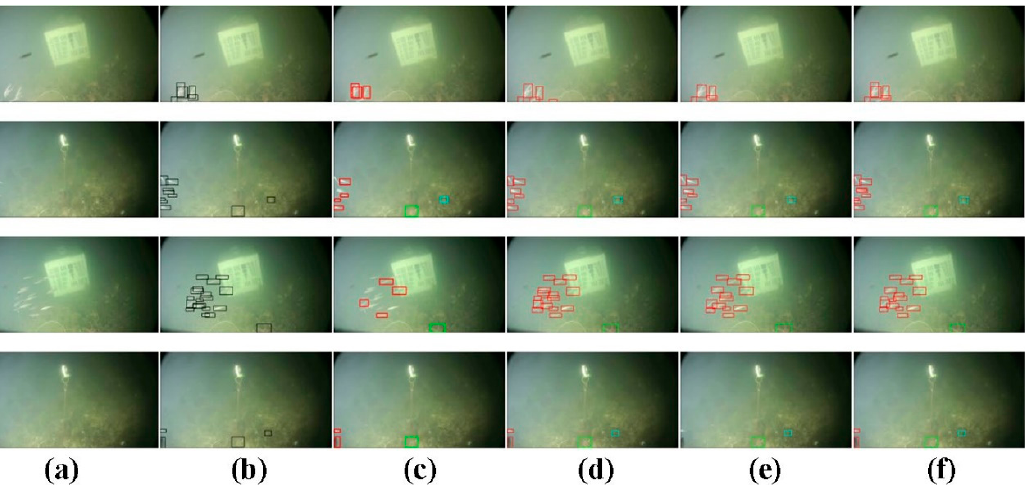
Figure 4. Comparison of target detection results. ( a ) Original picture. ( b ) Correct annotation. The target detection result of ( c ) SSD, ( d ) Faster RCNN, ( e ) YOLOv3, and ( f ) YOLOv3-brackish.